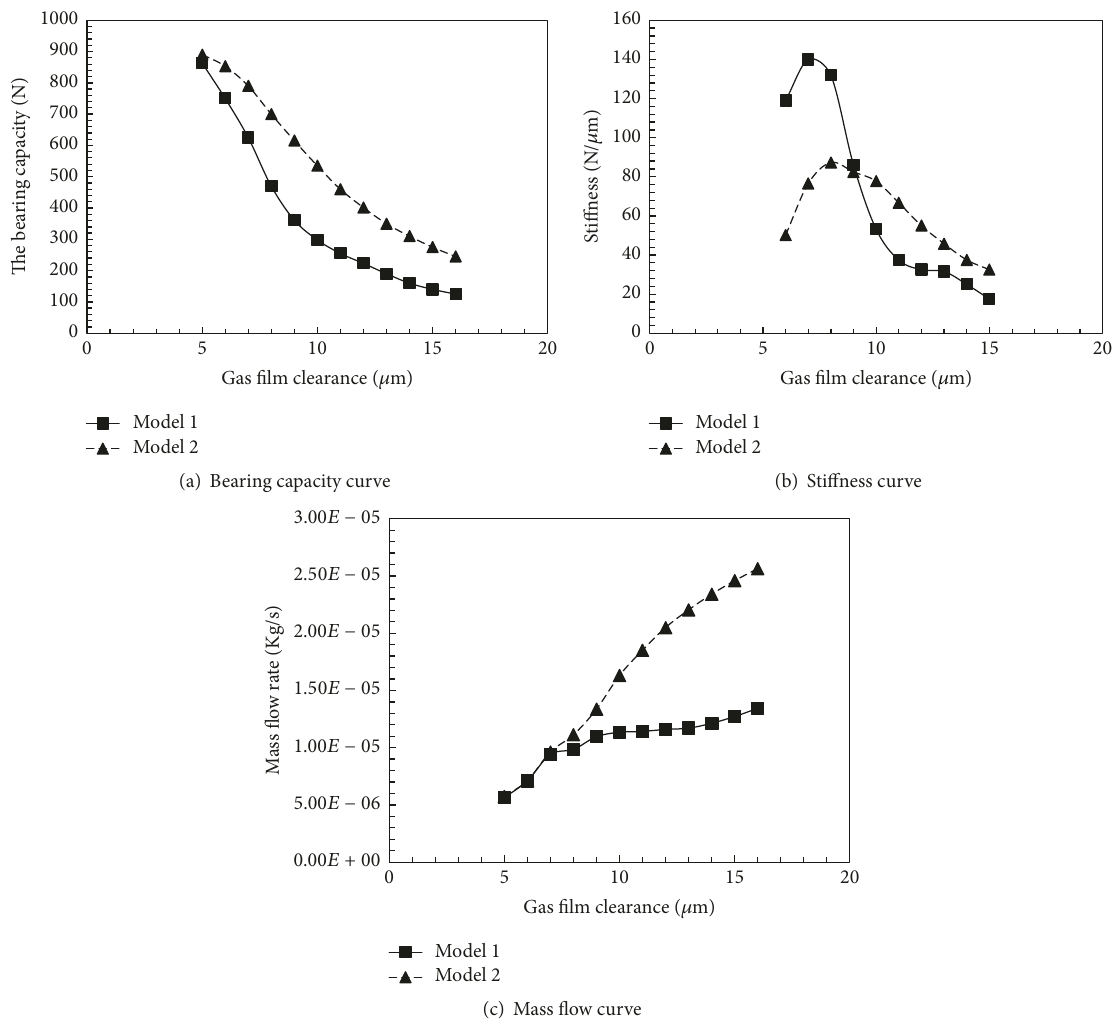
Figure 8: Performance comparison curves of two kinds of aerostatic bearing with different pressure equalizing grooves.